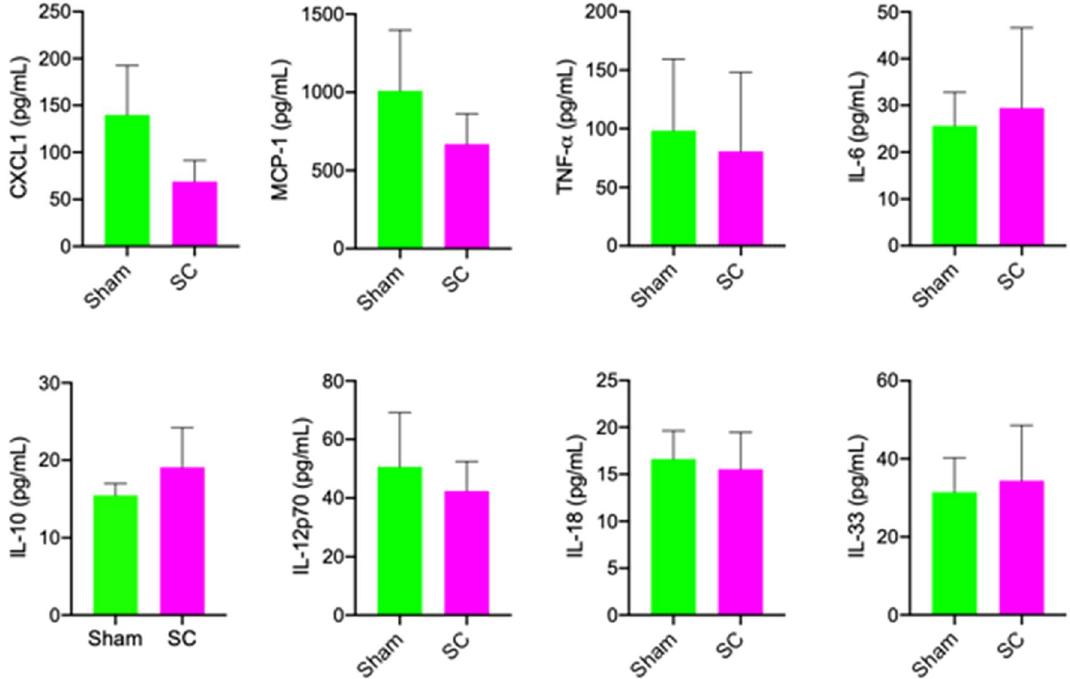
Figure 4. Plasma inflammatory cytokines. The plasma concentrations of pro- and anti-inflammatory cytokines were measured with flow cytometry beads array in rats receiving sub-concussion (SC) or sham procedure for 2 weeks. The data is shown as mean ± SEM. Statistical significance was assessed with unpaired t-test (* p <